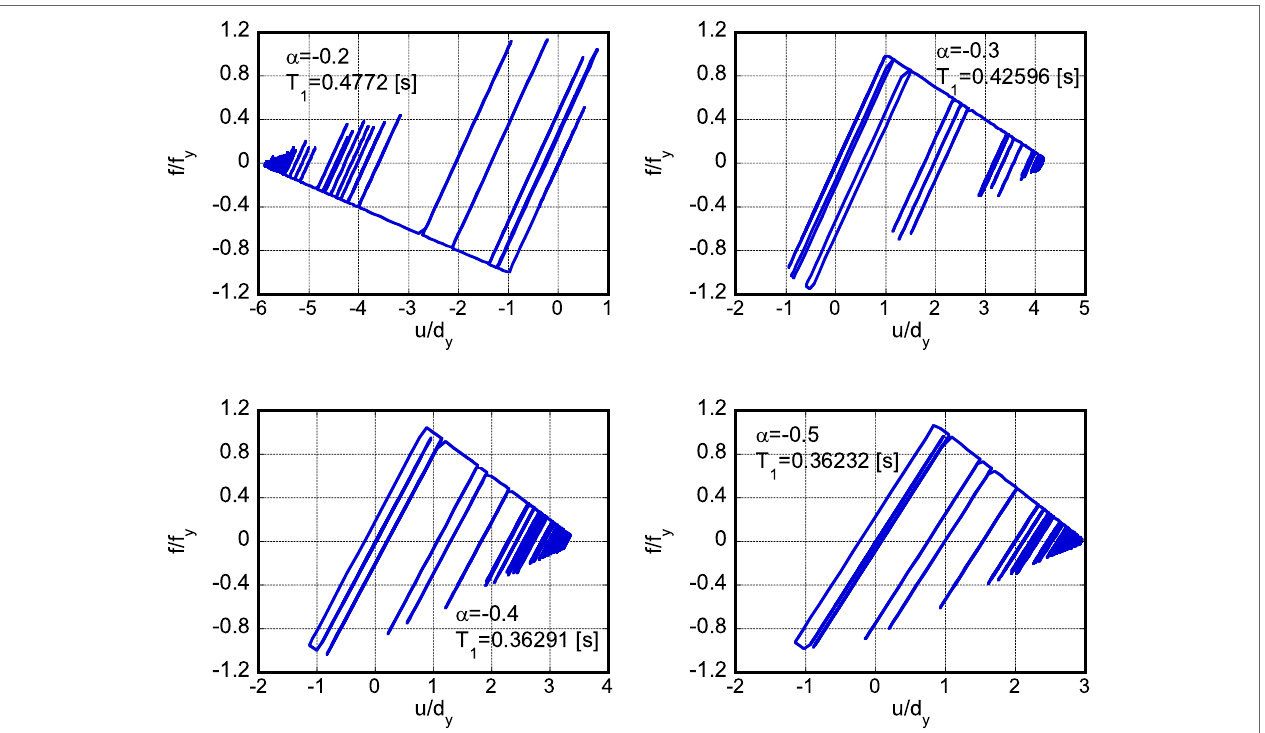
FIGURE 9 | Restoring-force characteristics of models with different second slopes under 2016 Kumamoto earthquake ground motion (April 16) designed so that they just collapse after one single impulse .